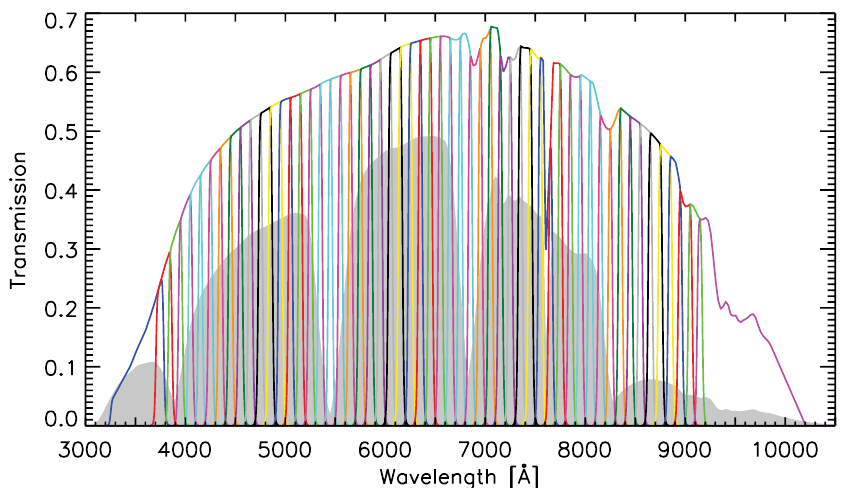
Figure 9. The transmission curves that characterize the quasi-spectroscopy of J-PAS. Shown are the 54 Figure1. Transmissioncurvesofthe54narrowbandandtwomedium-bandoverlappingJ-PASfiltersspanningtheopticalrange(colourlines).Thewidthof eachnarrow-bandfilteris 145Åandtheyarespacedby100Å.Forcomparison,thefiveSDSSfiltersareshownwithgrey-shadedshape. narrow-band and 2 medium-band filters that span the optical range (color lines). The narrow-band ∼ 2 THE J-PAS SURVEY filters feature a width of 145 Å and are spaced by 100 Å. Also shown (gray areas) are the five SDSS filters. From Reference